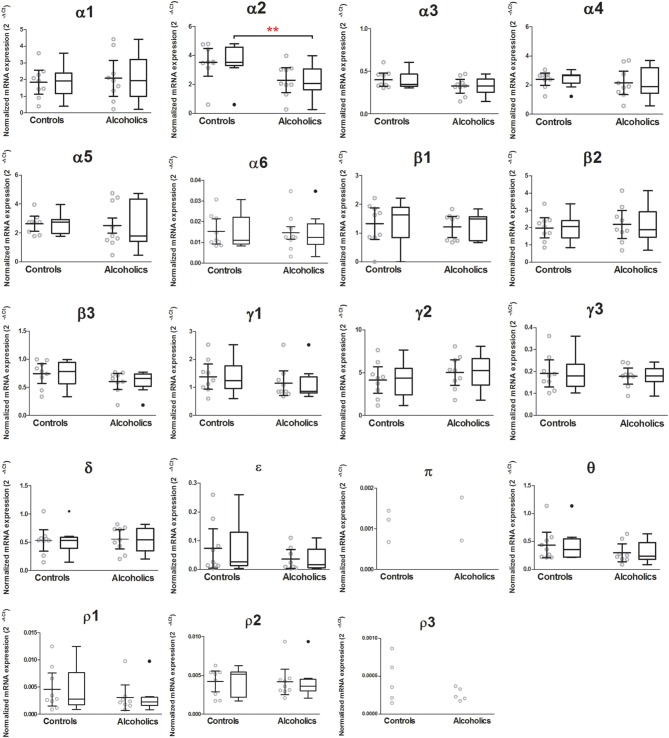
Expression of GABA-A receptor subunit mRNAs in the central amygdala of controls (n = 9) and alcoholics (n = 9). Data from each group were presented as scatter dot plot (◦) with mean and 95% confidence interval and box and whiskers plot with median and whiskers plotted by Tukey method to determine outliers (•–above or below the whiskers). Outliers were excluded from the statistical analysis. One-Way ANOVA with Bonferroni post-hoc test: α1, df = 14, p = 0.61; α2, df = 14, p = 0.0029; α3, df = 14, p = 0.12; α4, df = 14, p = 0.26; α5, df = 14, p = 0.50; α6, df = 14, p = 0.25; β1, df = 14, p = 0.78; β2, df = 14, p = 0.61; β3, df = 14, p = 0.36; δ, df = 14, p = 0.33; γ2, df = 14, p = 0.36; γ3, df = 14, p = 0.88; ρ2, df = 14, p = 0.20; θ, df = 14, p = 0.55. Kruskal–Wallis ANOVA on ranks with Dunn's post-hoc test: ε, H(1, 17) = 1.12, p = 0.29; γ1, H(1, 17) = 3.00, p = 0.083; ρ1, H(1, 16) = 2.36, p = 0.13. **p < 0.01.